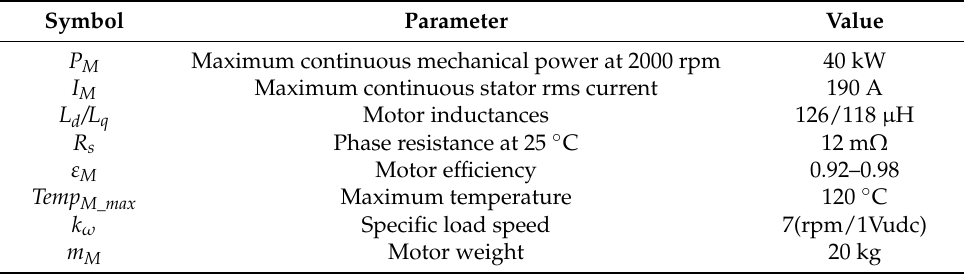
Table 3. Parameters of the air-cooled EMRAX 268 VHML MVAC motor.